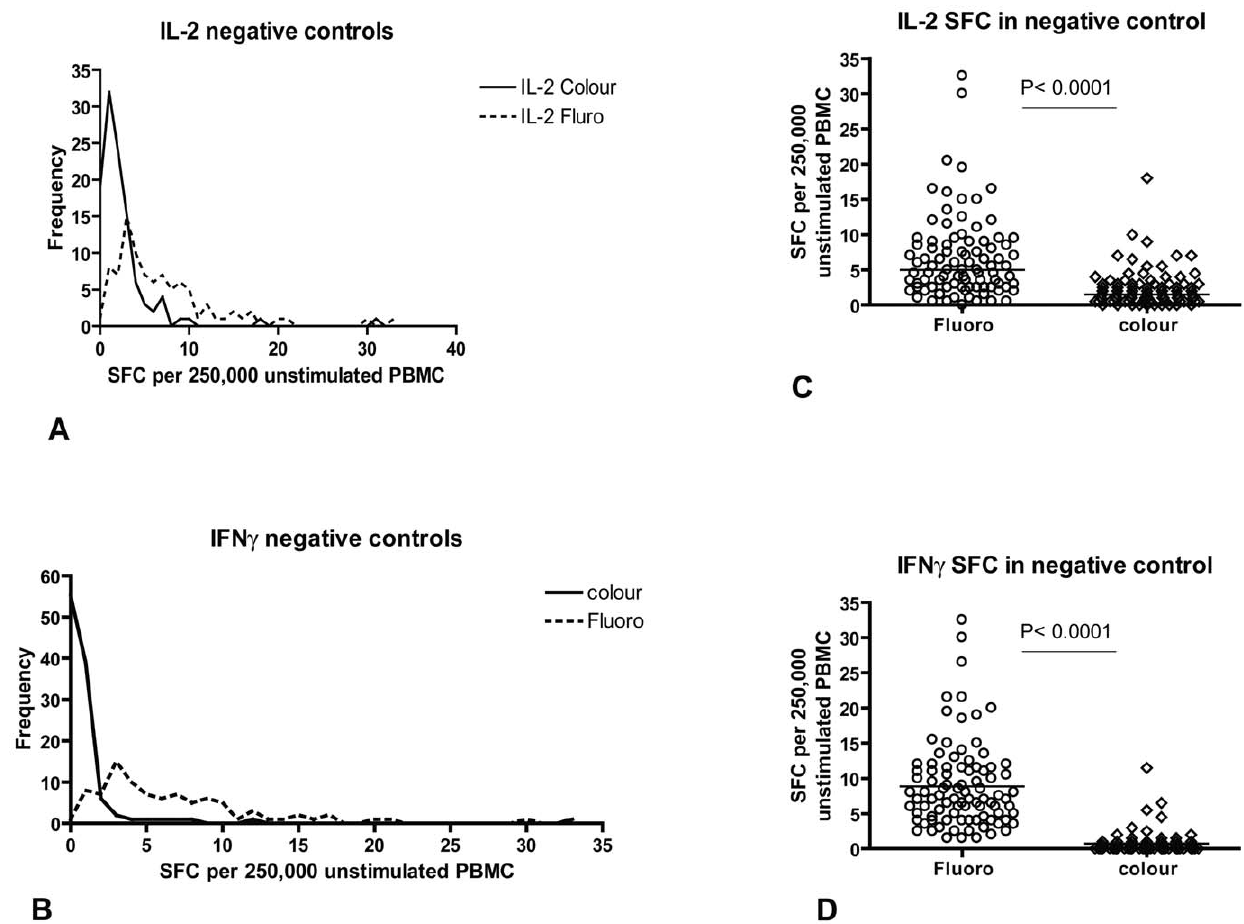
Figure 1. Comparison of number of spot-forming-cells (SFC) found in negative control wells of fluorescence-immunospot and colour ELISpot. Overlaid histograms of number of spot-forming-cells (SFC) found in negative control wells of colour ELISpot and fluorescence- immunospot measuring IL-2 (A) and IFN- c (B). Median values for IL-2 SFC and IFN- c SFC were higher in the fluorescence-immunospot compared to the colour ELISpot (C & D, both P , 0.0001). This was attributed to the use of co-stimulatory anti-CD28 antibody in the fluorescence-immunospot to overcome the effects of sequestering of IL-2 by membrane-bound IL-2 antibodies. The resultant increased background cytokine-secretion in negative control wells was adjusted for by subtracting negative control responses from antigen-specific